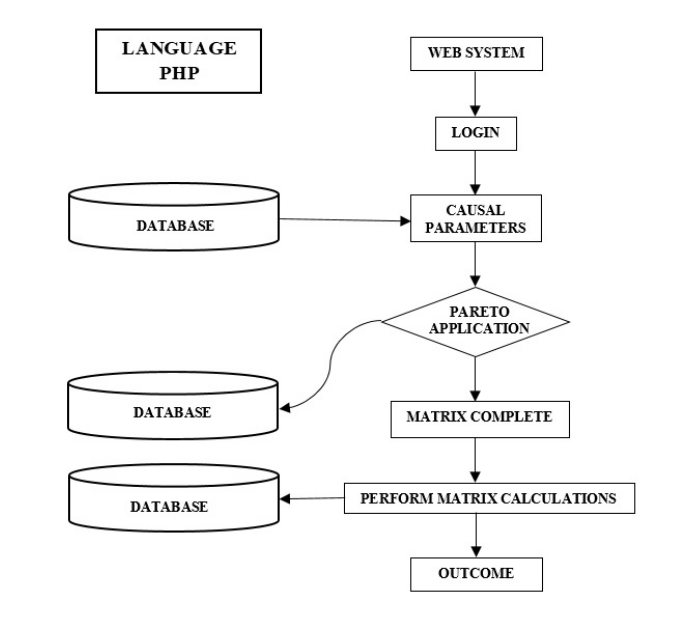
Figure 3. Systematization of the loop matrix. Table 1. Example of a causal